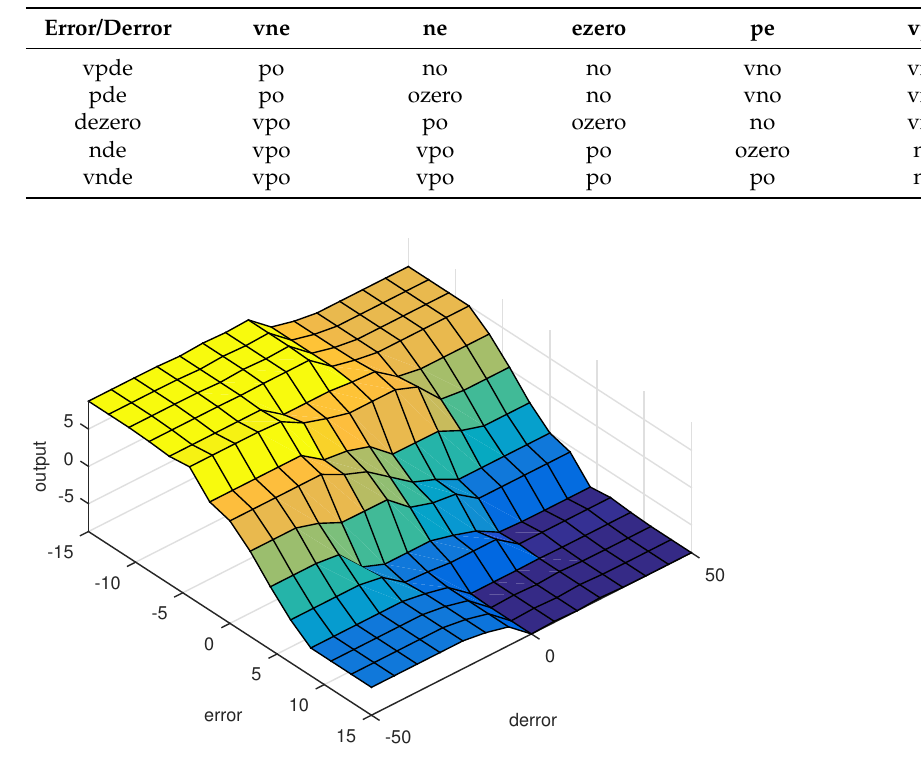
Table 2. Fuzzy rules for the inference engine.